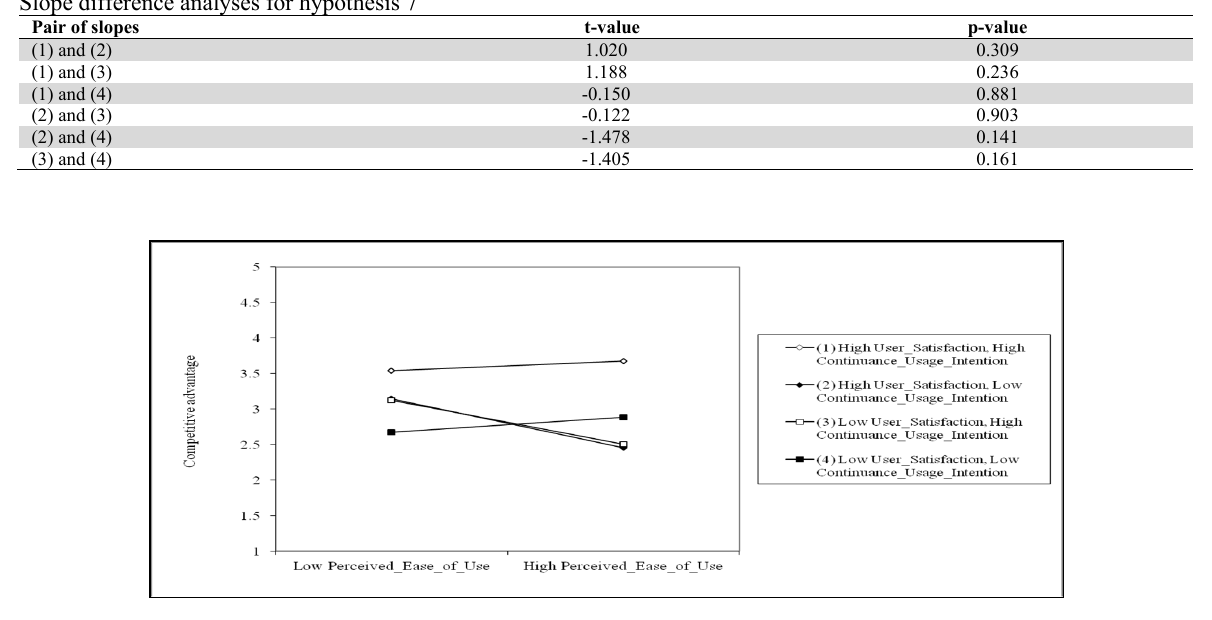
Fig. 5. Interaction effects of user satisfaction & e-HRM continuance usage intention between e-HRM-PEOU & SCA (Sources: Gaskin, 2016)